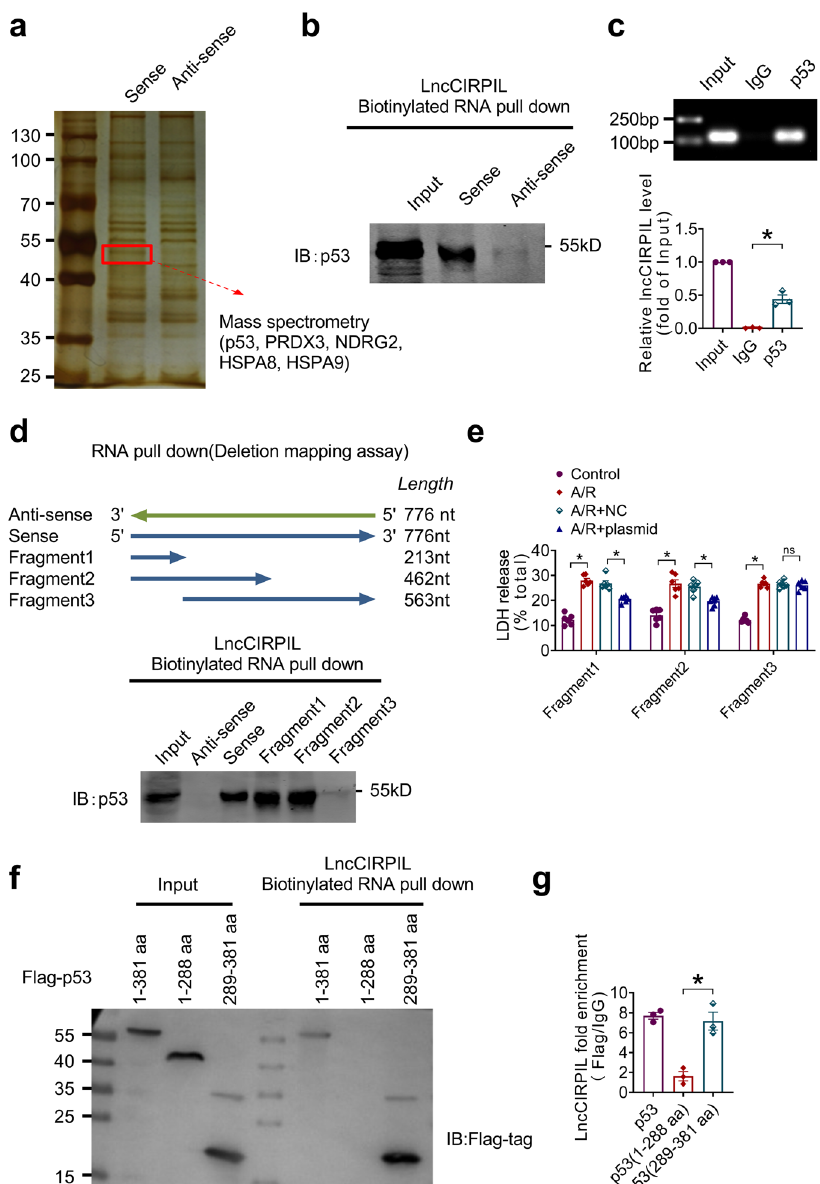
Fig. 5 LncCIRPIL binds with p53. a Silver staining of electrophoretic separated proteins pulled down by sense and antisense sequences of lncCIRPIL. Mass spectrometry was performed on the band speci fi cally pulled down by sense sequence and p53 was identi fi ed. b Western blot of p53 pulled down by sense sequence of lncCIRPIL. n = 3. c LncCIRPIL immunoprecipitated by anti-p53 antibody. n = 3. * P < 0.05 vs IgG by two-tailed Student ’ s t test. d Western blot of p53 pulled down by biotin-labeled fragments of lncCIRPIL. n = 3. e Effects of fragments of lncCIRPIL on LDH release of NMCMs subjected to anoxia/ reoxygenation(A/R) insult. n = 6 samples from 3 independent experiments for each group. * P < 0.05 by one-way ANOVA followed by Tukey post hoc analysis. f Western blot of fl ag-labeled fragments of p53 pulled down by sense sequence of lncCIRPIL. n = 3. g LncCIRPIL immunoprecipitated by anti- fl ag antibody for fl ag-labeled fragments of p53. n = 3. * P < 0.05 by one-way ANOVA followed by Tukey post hoc